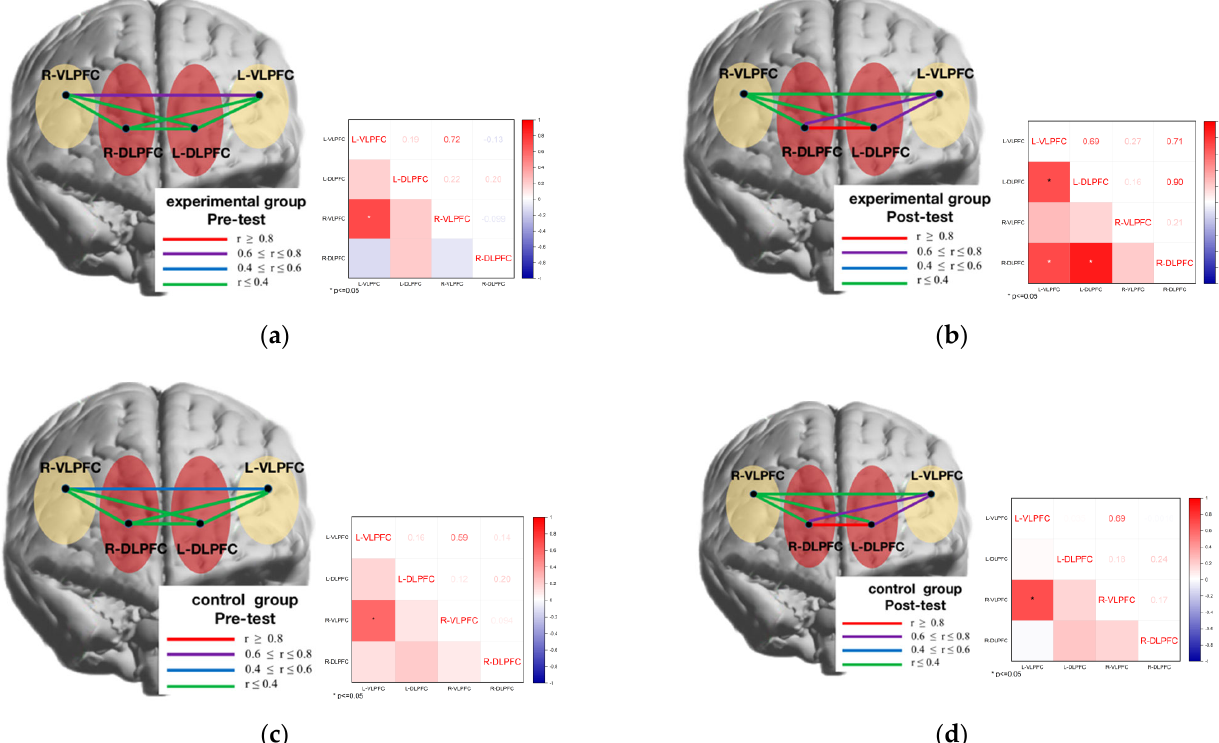
Figure 12. Correlation of brain network functional connectivity in different groups before and after exercise intervention. Brain network connectivity analysis between the four prefrontal regions of interest. ( a ) Pre ‐ test phase in the experimental group; ( b ) post ‐ test phase in the experimental group; ( c ) pre ‐ test phase in the control group; ( d ) post ‐ test phase in the control group. Brain area maps: red area represents dorsolateral prefrontal lobe (DLPFC); yellow represents ventral lateral prefrontal lobe (VLPFC). Correlations between brain areas are represented by connecting lines: red represents r ≥ 0.8; purple represents 0.6 ≤ r ≤ 0.8; blue represents 0.4 ≤ r ≤ 0.6; green represents r ≤ 0.4. Correlation hotspot: red represents positive prior correlation; blue represents negative correlation; and the darker the color, the greater the correlation. * represents p < 0.05.